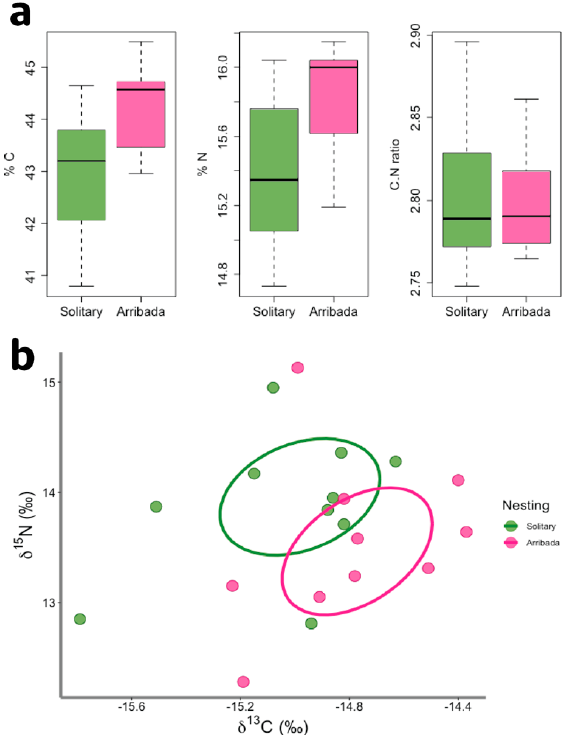
Figure 4. Stable isotope analysis. ( a ) Comparison of %C ( p = 0.013) and %N ( p = 0.014) and C:N ( p > 0.05) ratio between solitary and arribada nesters, ( b ) δ 13 C and δ 15 N ratios. Standard ellipses represent a 40% overlap between nesting modes.